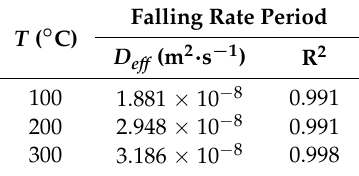
Figure 6. Plot of ln D eff versus m/P of lignite. ( a ) 1st falling rate period; ( b ) 2nd falling rate period. Table 9. Activation energy of lignite at different temperatures during microwave drying. Table 8. Effective diffusion coefficient of lignite at different temperatures during hot-air